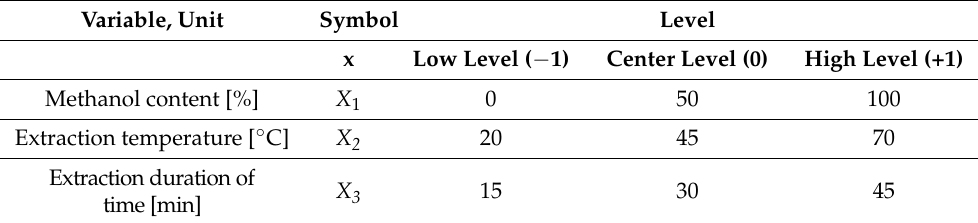
Table 4. Levels and code of variable chosen for Box–Behnken